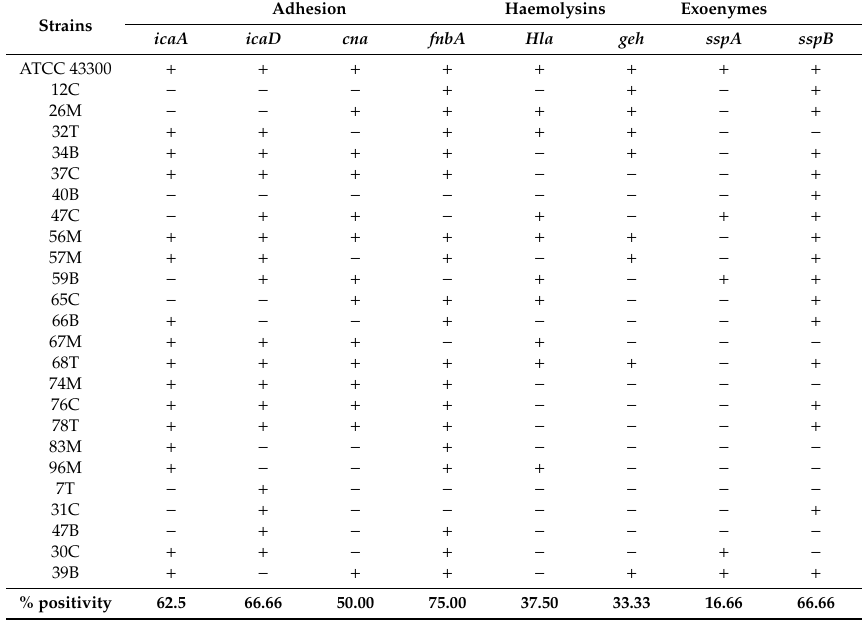
Table 5. Distribution of biofilm related genes ( icaA , icaD , cna , fnbA ), α -hemolysin ( hla ), and exoenzymes genes ( geh , sspA , sspB ) in Staphylococcus spp. strains